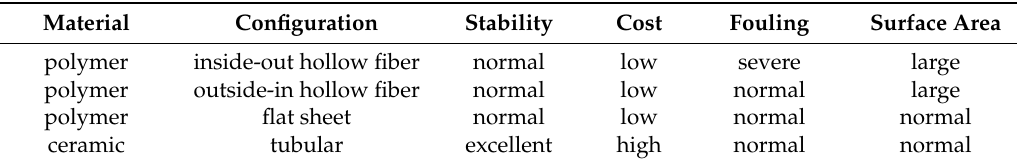
Table 5. Comparison of different kinds of membrane in